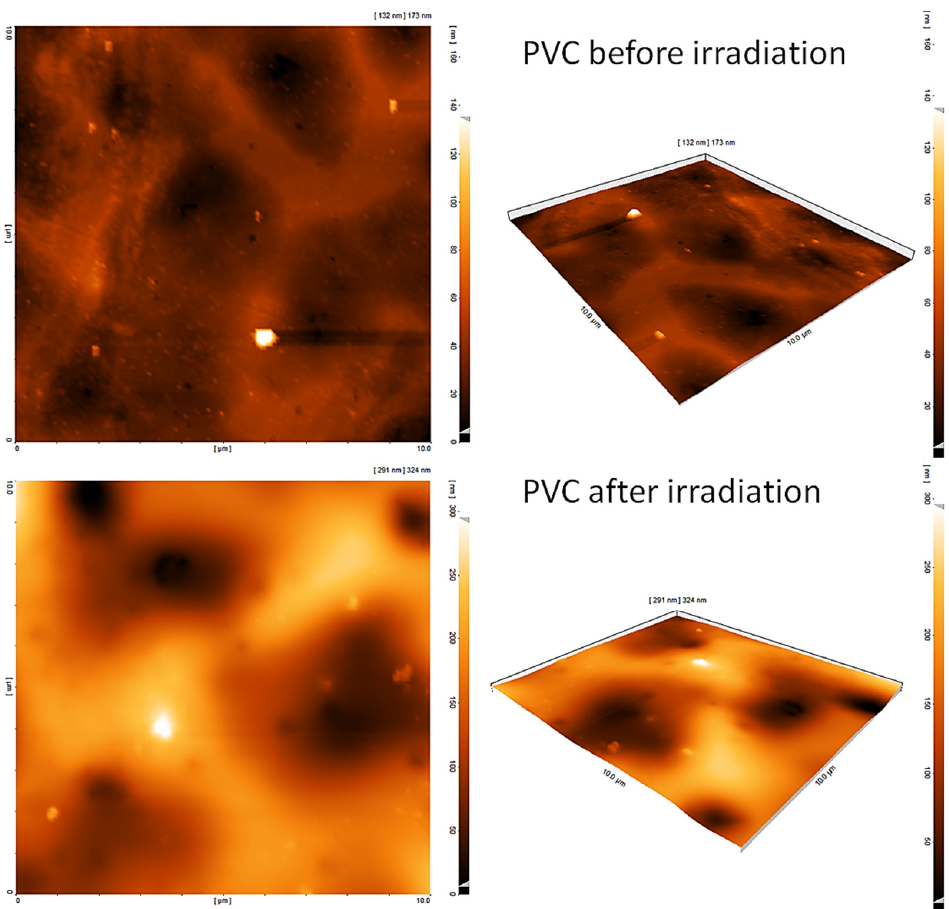
Figure 9. Atomic force microscopy (AFM) images of the blank PVC before and after irradiation.